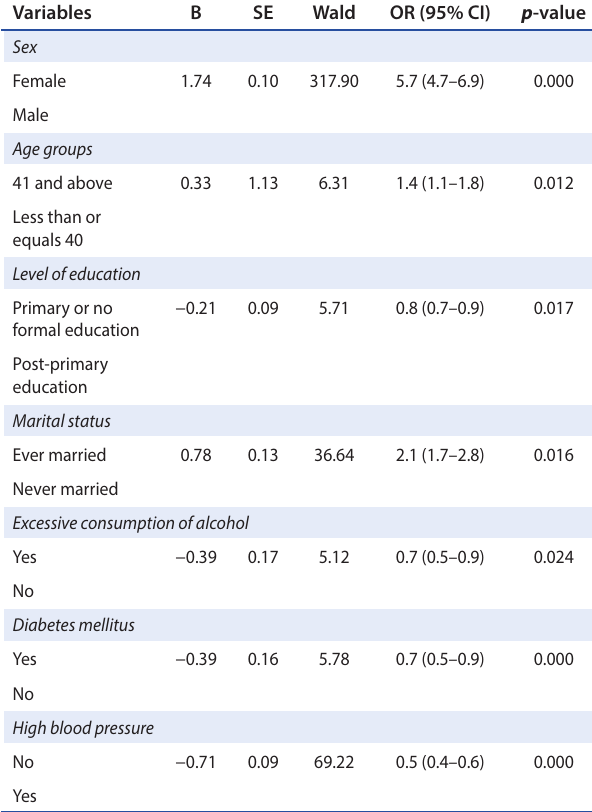
Notes: OR = odds ratio; SE = standard